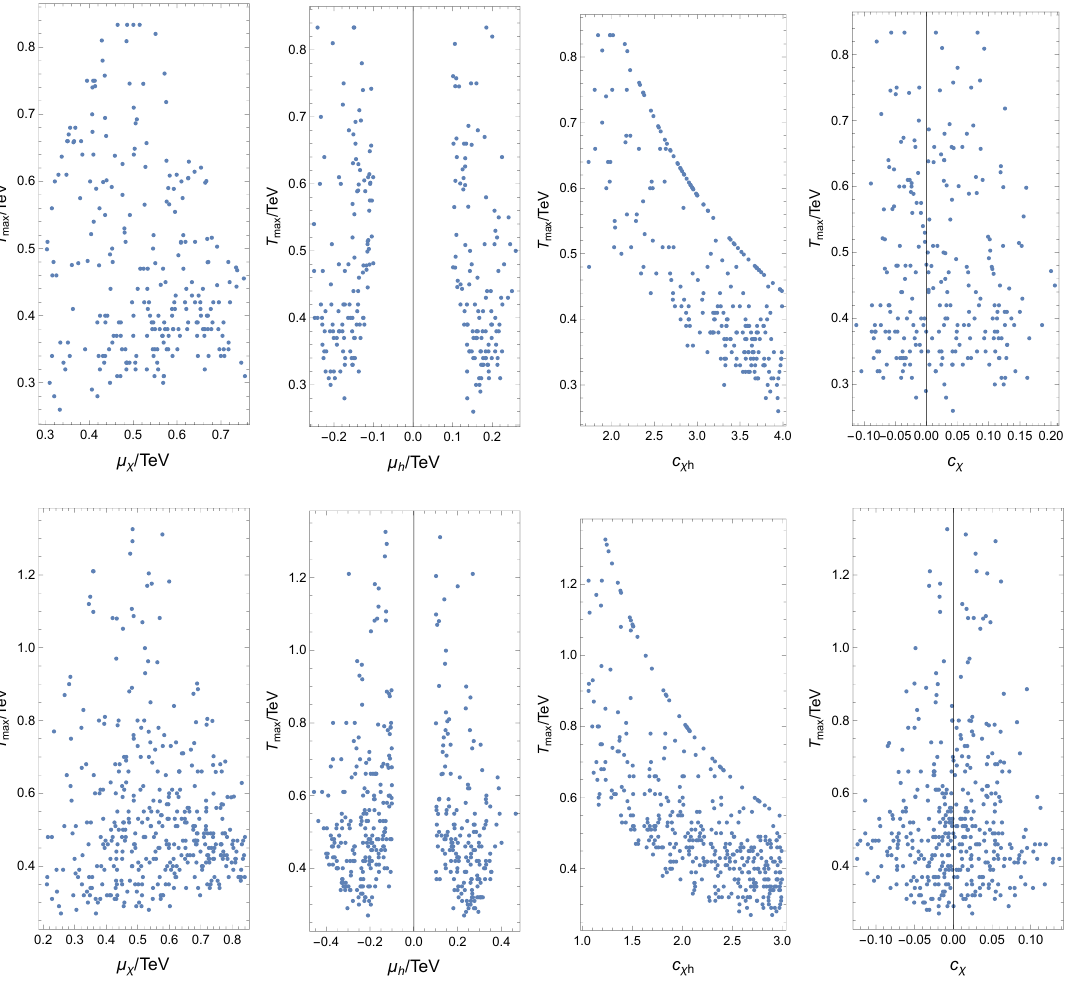
Figure 5 . Maximal SNR temperature as a function of µ χ , µ h , c χh and c χ where in the upper panels we fix n χ = 10 , Λ = 2 . 5 TeV , tan β = 1 , m H,H n χ = 30 , Λ = 4 TeV , tan β = 1 , m H,H